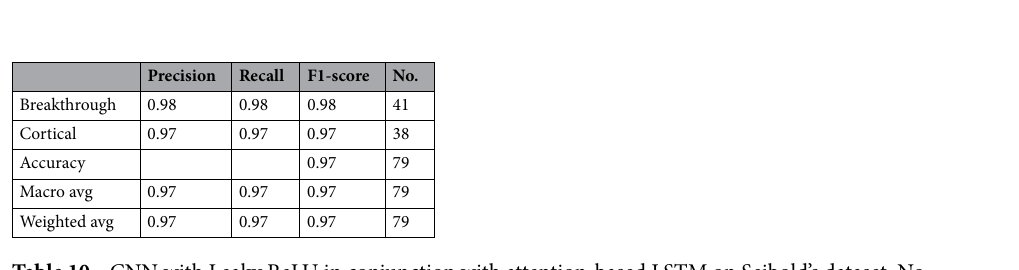
Table 10. CNN with Leaky ReLU in conjunction with attention-based LSTM on Seibold’s dataset. No. indicates the number of samples.